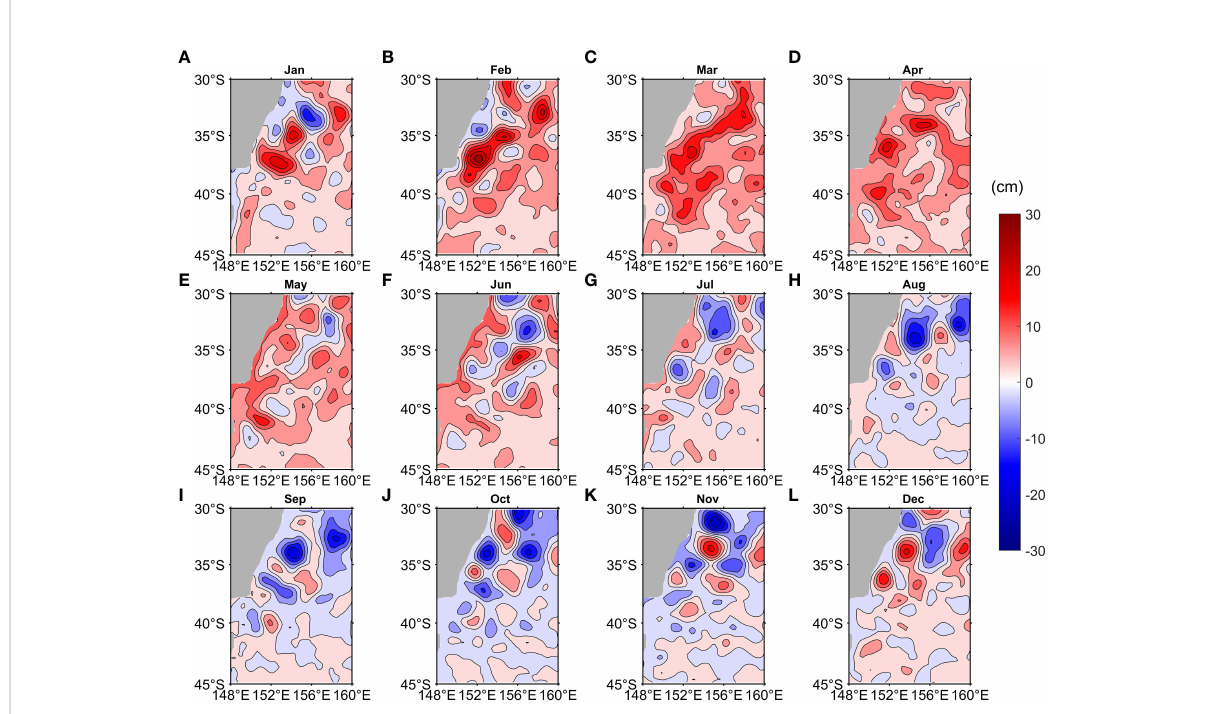
FIGURE 12 Monthly mean Sea Level Anomalies (SLA, Unit: cm) distribution from AVISO during January 1999-December 2009 for (A) January, (B) February, (C) March, (D) April, (E) May, (F) June, (G) July, (H) August, (I) September, (J) October, (K) November and (L)